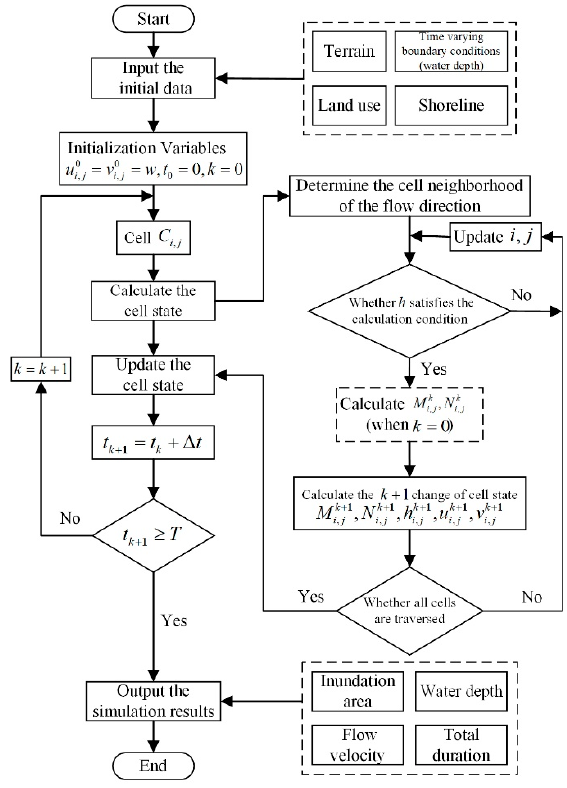
Figure 6. Flowchart of the cellular automata (CA) model calculation.